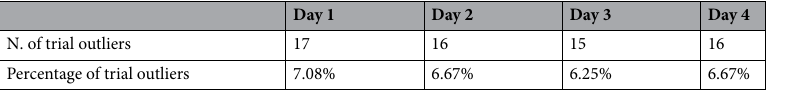
Table 1. Number of trial outliers discarded in all participants for each day of the first experiment on the basis of the computed Thickness . The Thickness threshold was set to the average value plus two times the standard deviation.